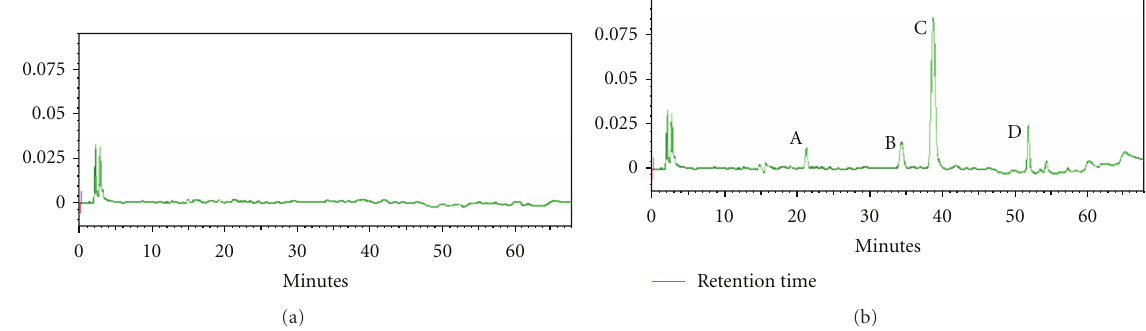
Figure 2: HPLC Chromatograms of A: Cherimolin-1, B: annonacin, C: Squamocin, D: annonin-VI. (a) blank K-R bu ff er solution; (b) the four compounds in ACGs extract.